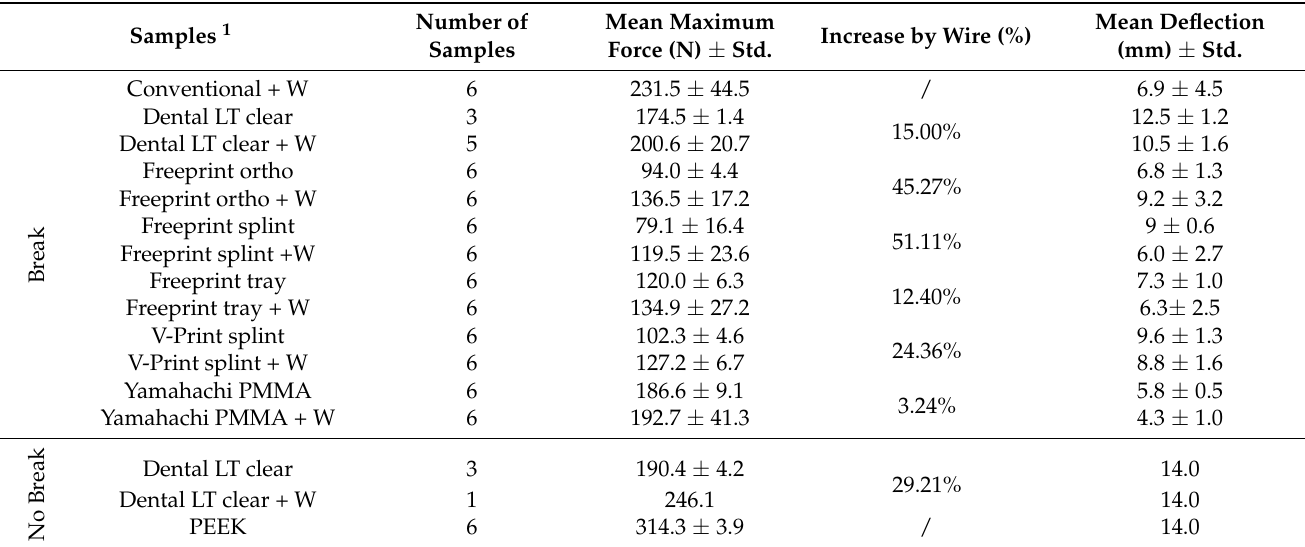
Table 3. Mean maximum force (N) and mean deflection (mm) values. Results of specimens with (+W) and without wire are shown, as well as the number of samples for each scenario (break or no break).